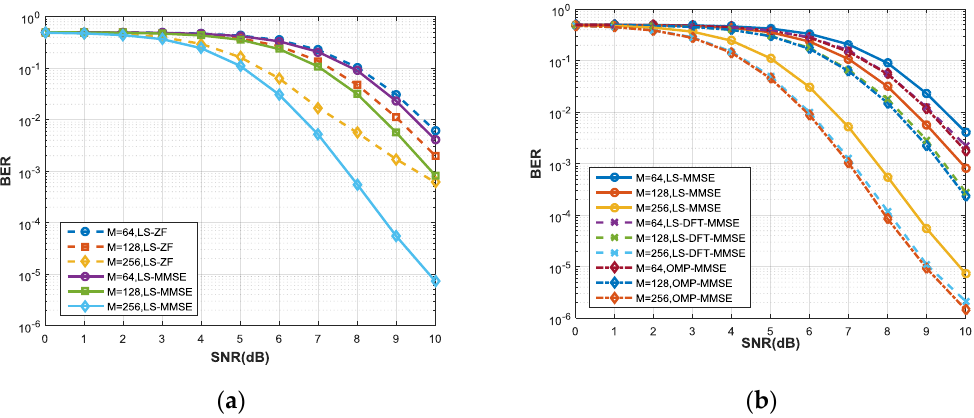
Figure 11. The system performance comparison: ( a ) comparison of zero forcing (ZF) and minimum mean square error (MMSE) equalization methods with different vector lengths; ( b ) comparison of least squares (LS), discrete Fourier transform-based least squares (LS-DFT), and orthogonal matching pursuit (OMP) estimation methods with MMSE equalization method and different vector lengths.